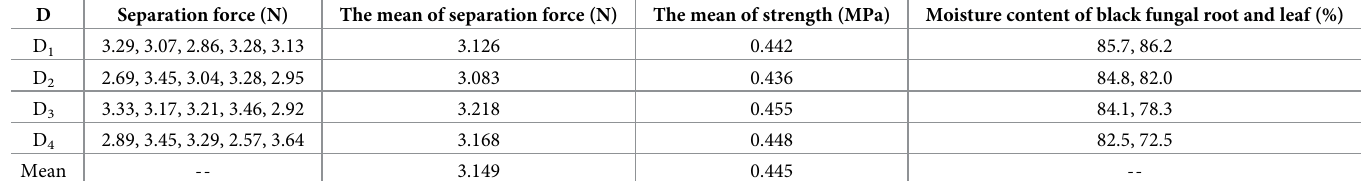
Table 4. Separation force of black fungus and the sticks with different moisture content. D